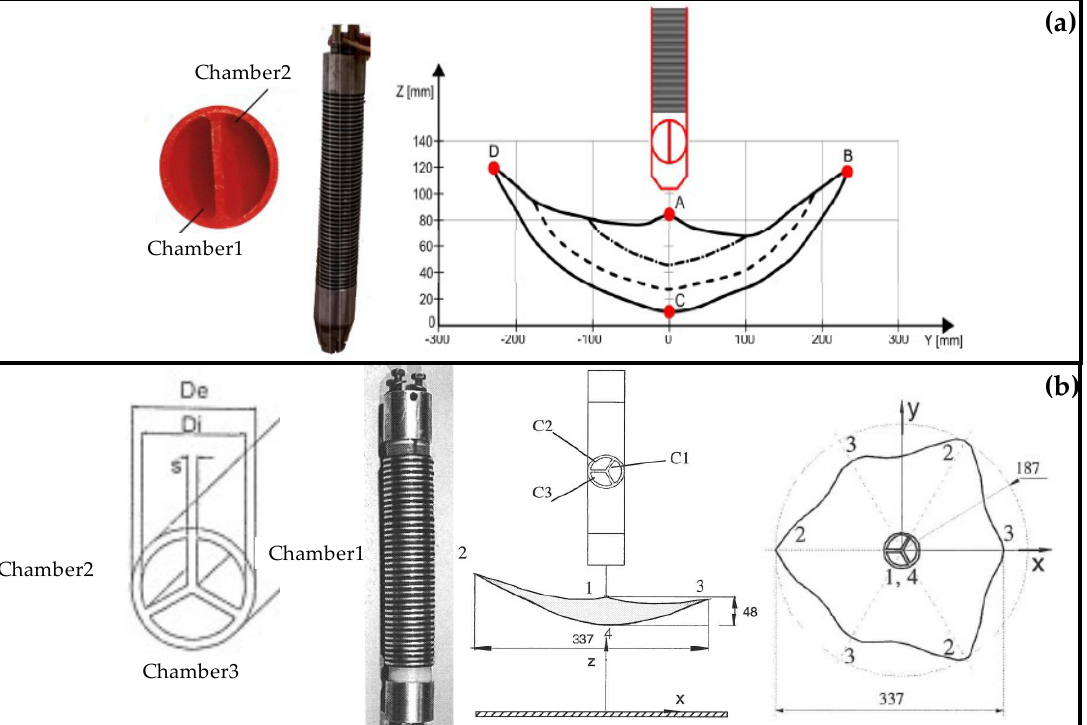
Figure 8. Bending actuators prototypes with two (( a ) [32,49]), and three chambers (( b ) [36,50]) and their related workspaces.